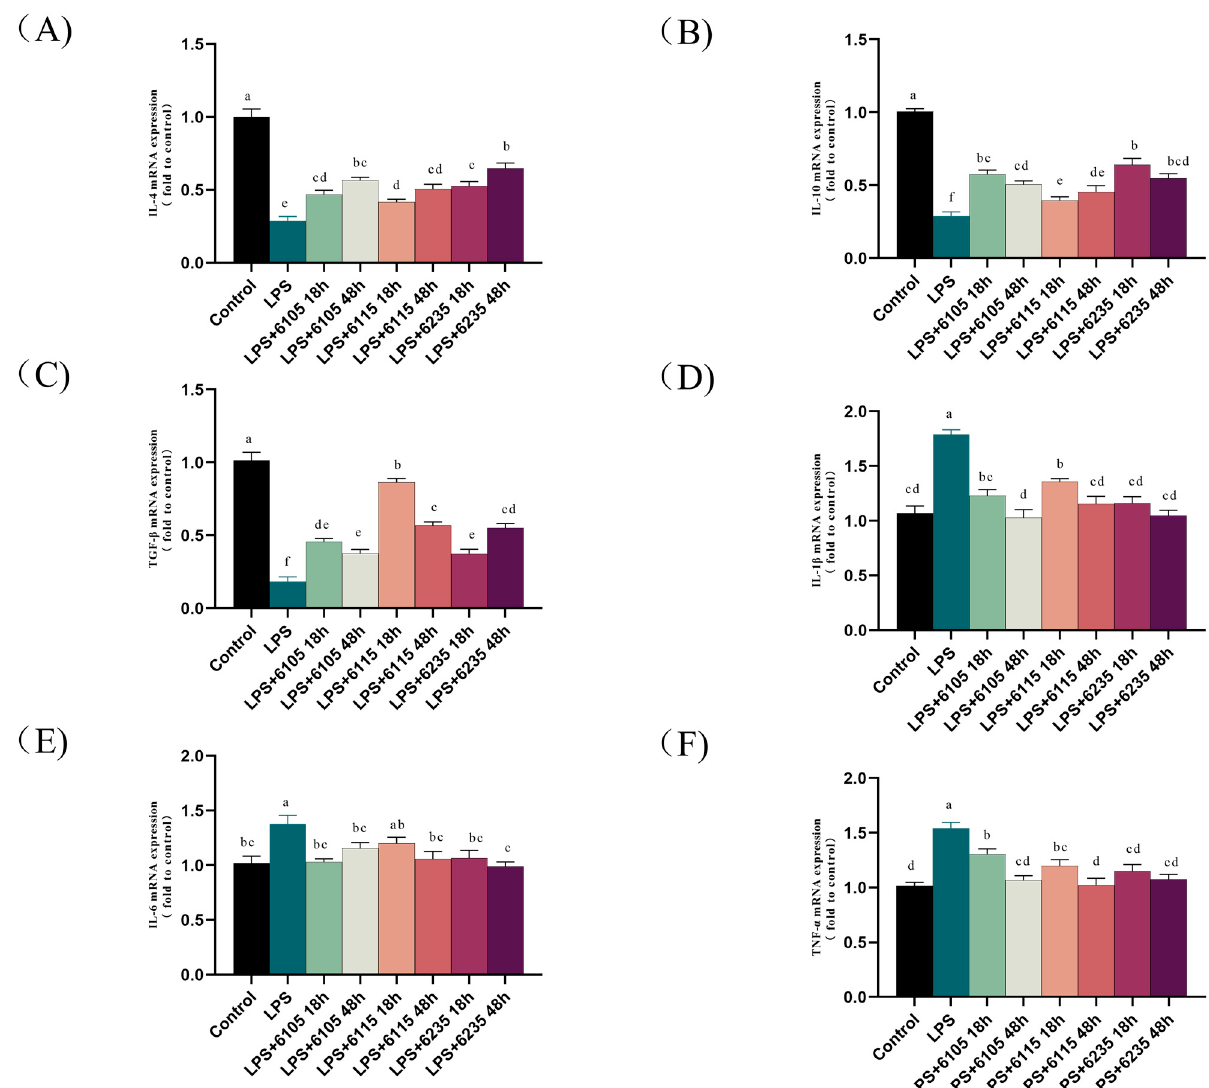
Figure 3. Interleukin (IL)-4 ( A ), IL-10 ( B ), transforming growth factor beta (TGF- β ) ( C ), IL-1 β ( D ), IL-6 ( E ), and TNF- α ( F ) mRNA levels in lipopolysaccharide (LPS) (100 µ g/mL)-induced Caco-2 cell monolayers treated with heat-killed L. paracasei (HK-LP) (1 µ g/mL). HK-LP 6105, 6115, and 6235 were incubated for 18 h and 48 h, respectively; after that, they were heat-killed for 30 min at 100 ◦ C. Control: untreated control cells; LPS: LPS-treated cells. Each result is represented as the mean ± standard error of the mean (SEM) from three independent experiments. Different lowercase letters (a, b, c, d, e, f) indicate different levels of significance ( p < 0.05) and the same letters represent no significant difference ( p > 0.05).